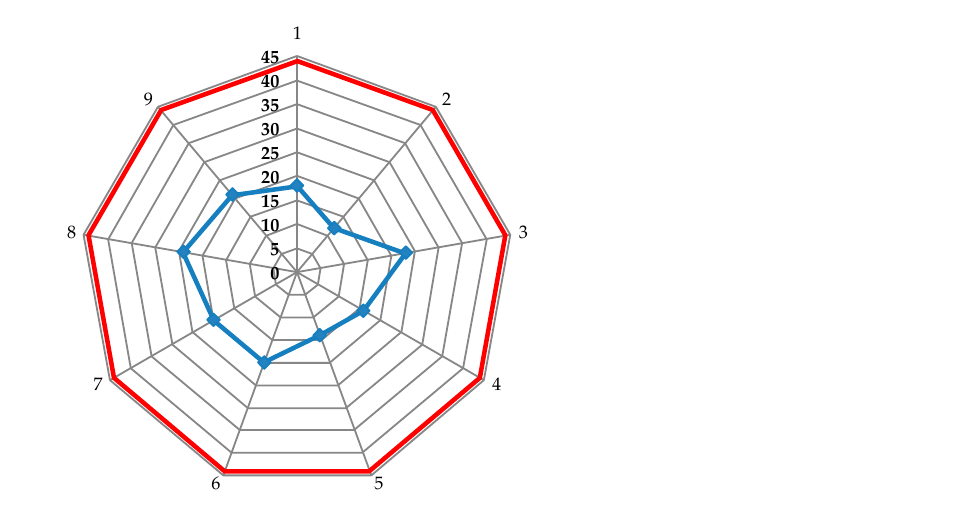
Figure 5. Data for BFS measured for 9 fires on three packages made of 12 layers of SB1plus fabric.